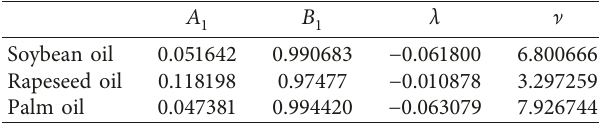
Table 4: Results of parameter estimation for EGAS (1,1)-SKST model.